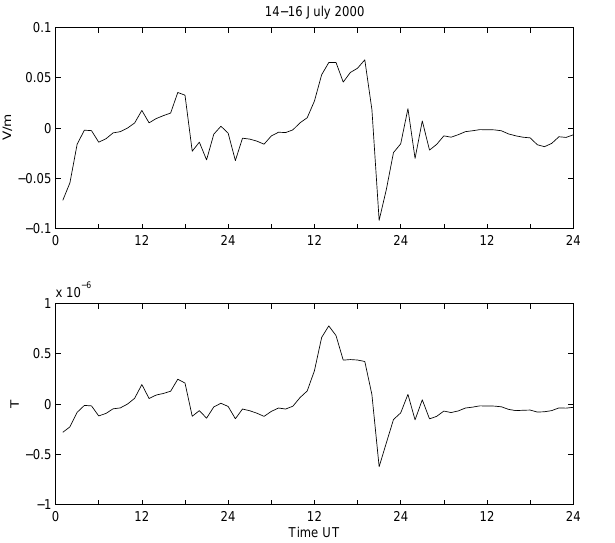
Fig. 6. Top panel: The northward component of the ionospheric electric field. Bottom panel: The deflection of the northward com- ponent of the magnetic field measured by the magnetometer in Kiruna.